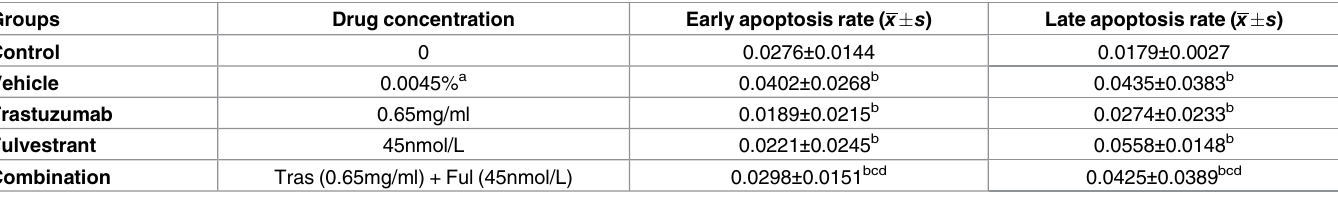
Table 3. Effects on ZR-75-1 cell apoptosis treated with trastuzumab and fulvestrant as single agents or with a combination of both. Groups